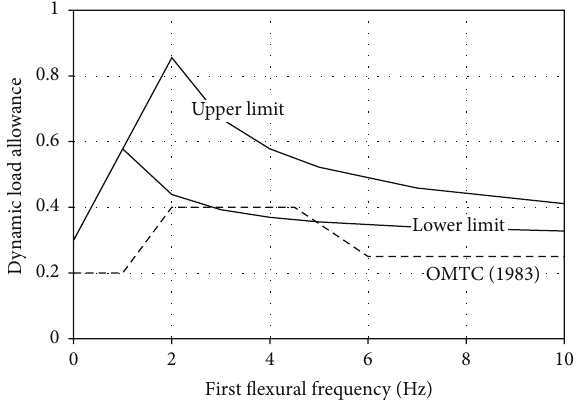
Figure 12: Relation between DLA and frequency.